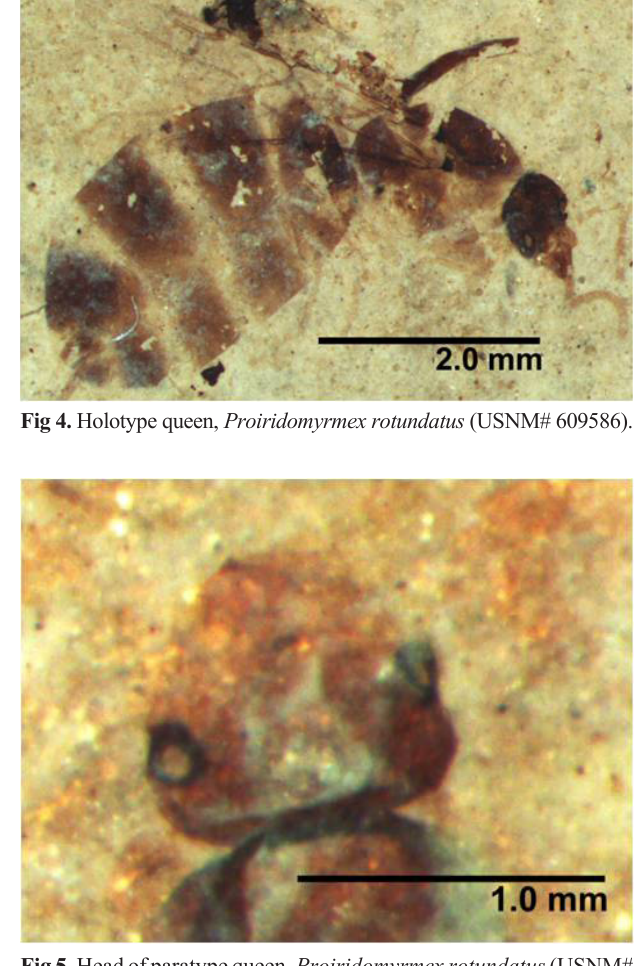
Fig 5. Head of paratype queen, Proiridomyrmex rotundatus (USNM# 609587).